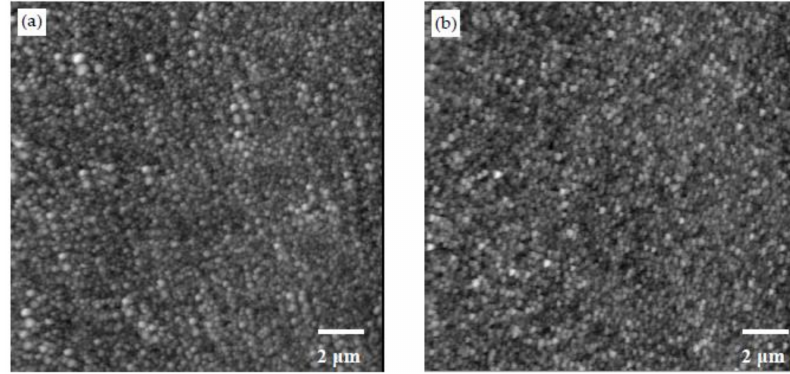
Figure 10. AFM images of PEI/PAA-CSH made of 25 bilayers ( a ) before and ( b ) after heat treatment.